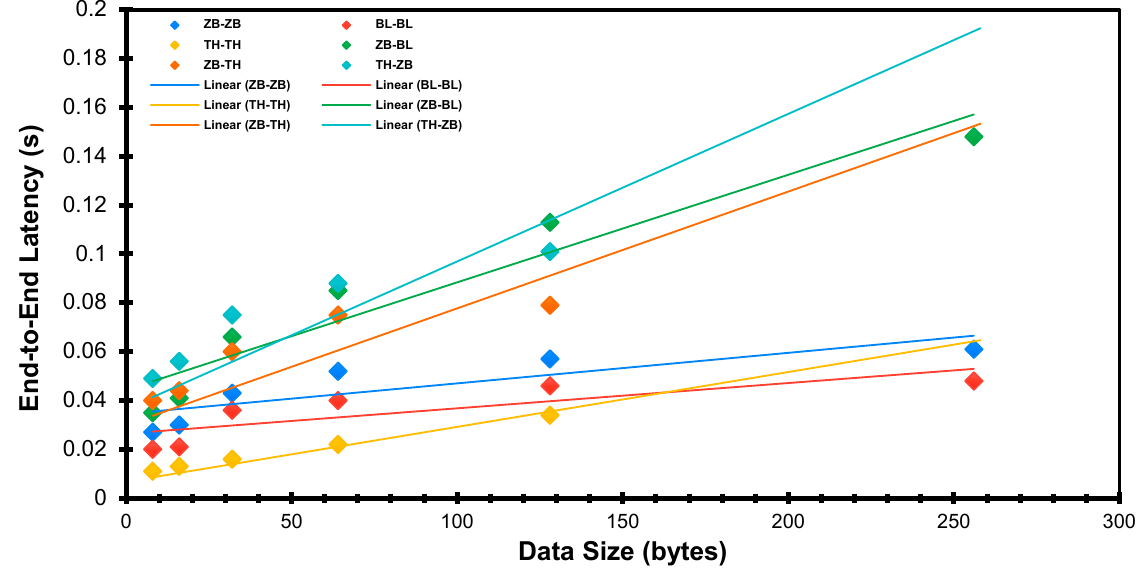
Figure 19. Combined End ‐ to ‐ End Latency Graphs for All Connection Pairs and Their Respective Regression Lines. Table 4. Univariate Regression Models Built Based on End ‐ to ‐ End Latency Experimental Outcomes.